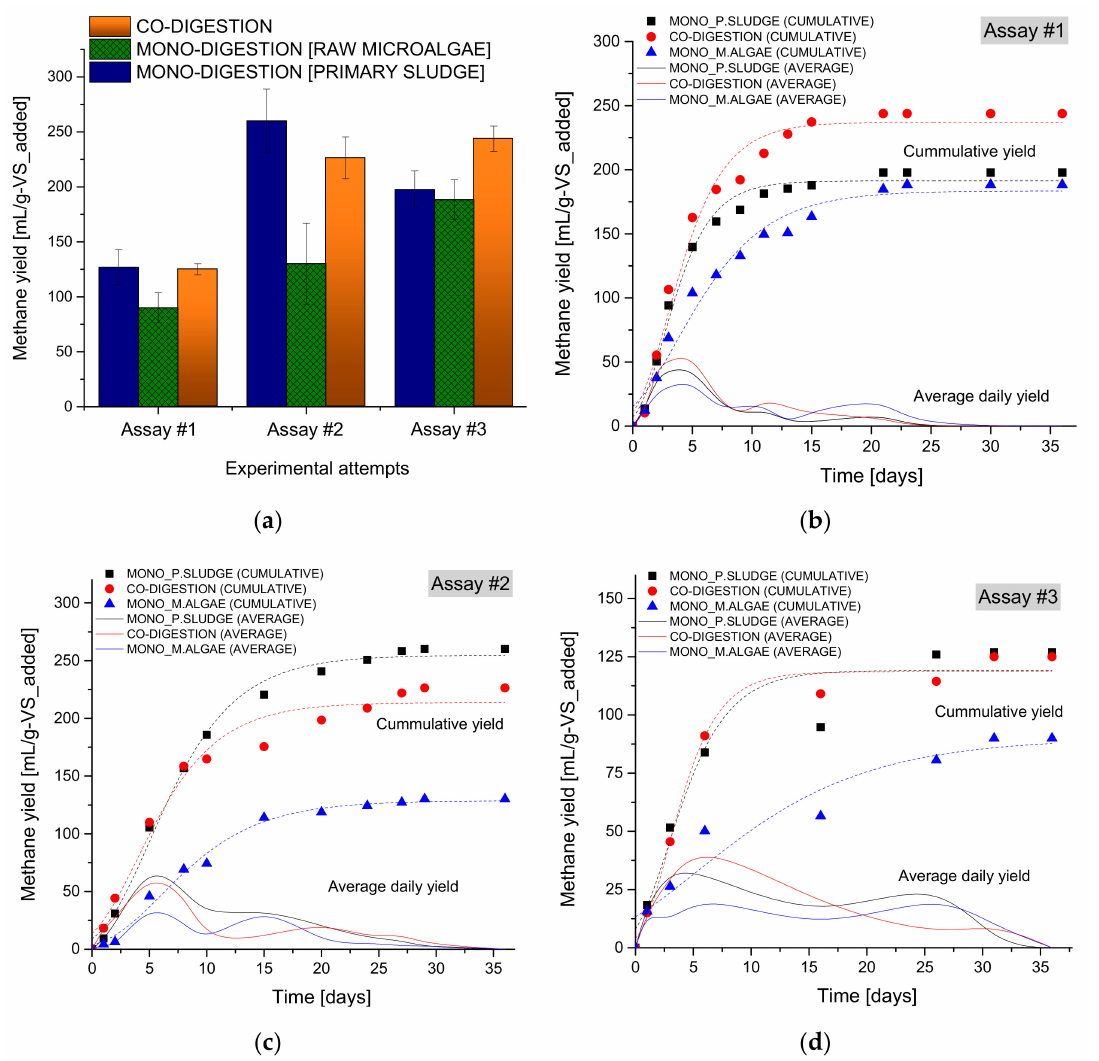
Figure 2. Methane yield without any biological pretreatment of microalgae: ( a ) experimental maximum methane yield from di ff erent trials with varying inoculums; ( b – d ) experimental vs. simulated values of thecumulativeyieldfromthreedi ff erentassays [Experimentalcondition: MesophilicADtemperature = 35 ◦ C, Sludge / algae ratio for co-digestion = 9, pH = 7.1 ± 0.2, ISR = 2, Working AD volume = 150 mL; Inoculum behavior = Assay #1: TS = 27.77 g / L, Assay #2: TS = 36.85 g / L, Assay #3: TS = 18.73 g / L]. Note: * The scattered points show measured cumulative values; the broken lines show the simulated trend; and the smooth spline line shows temporal variations of the average daily methane yield. In calculating the the VS_added, the contribution of inoculum was not